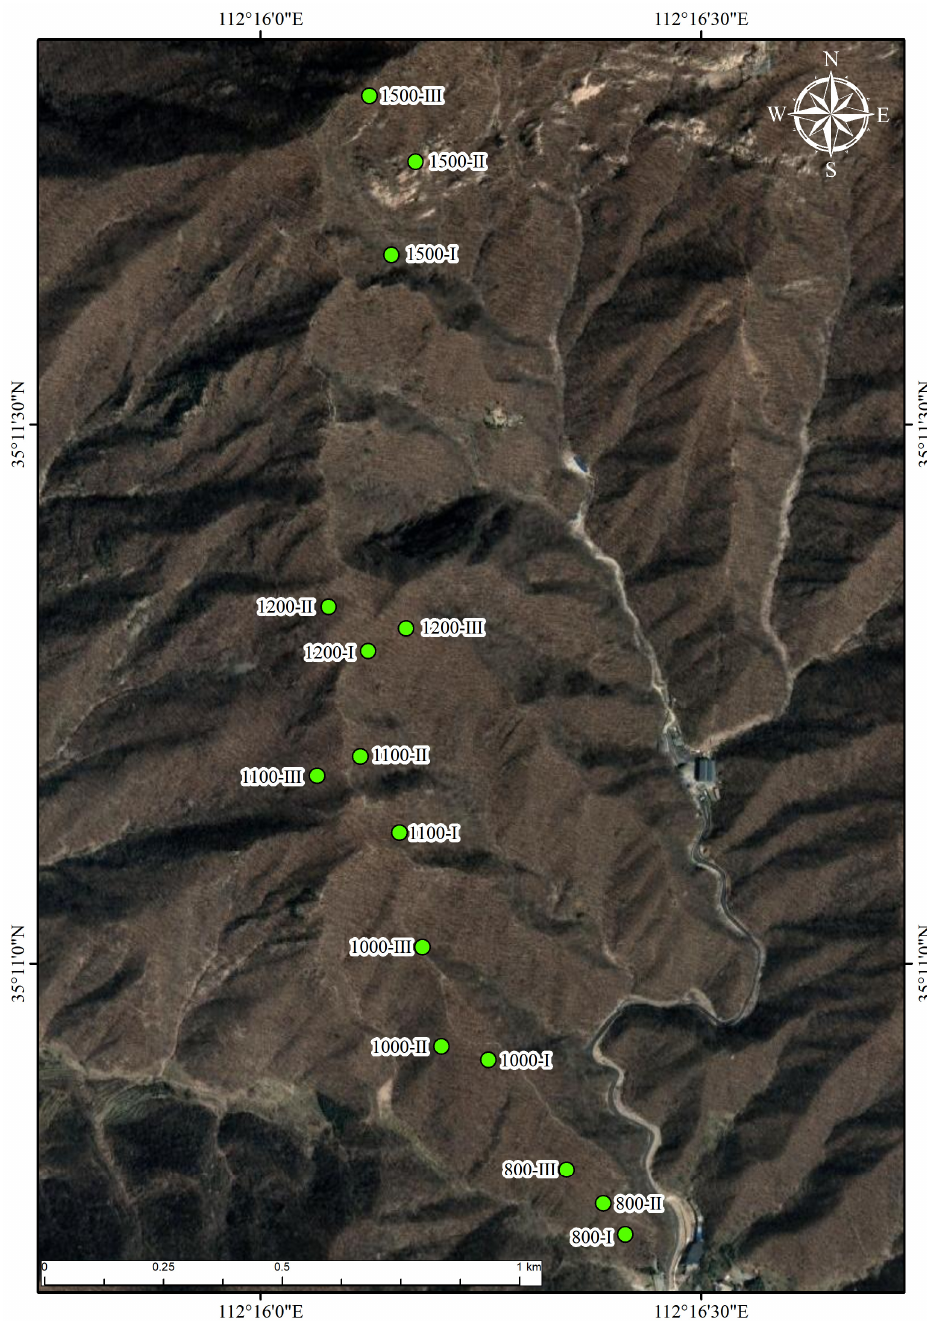
Figure 1. Map of the sampling sites in the Wangwu Mountain scenic